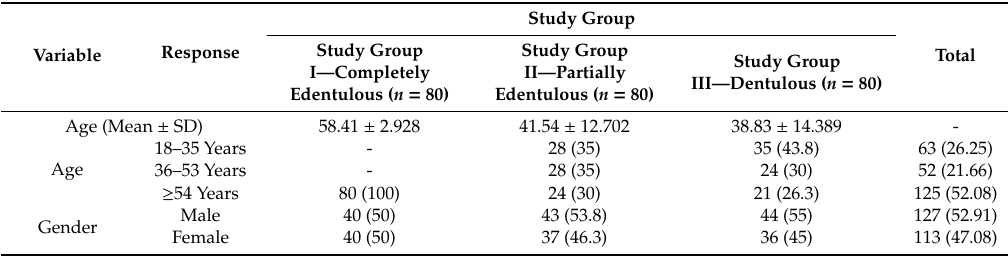
Table 1. Descriptive analysis of biographic data of study groups expressed as n (%) except for the “age”